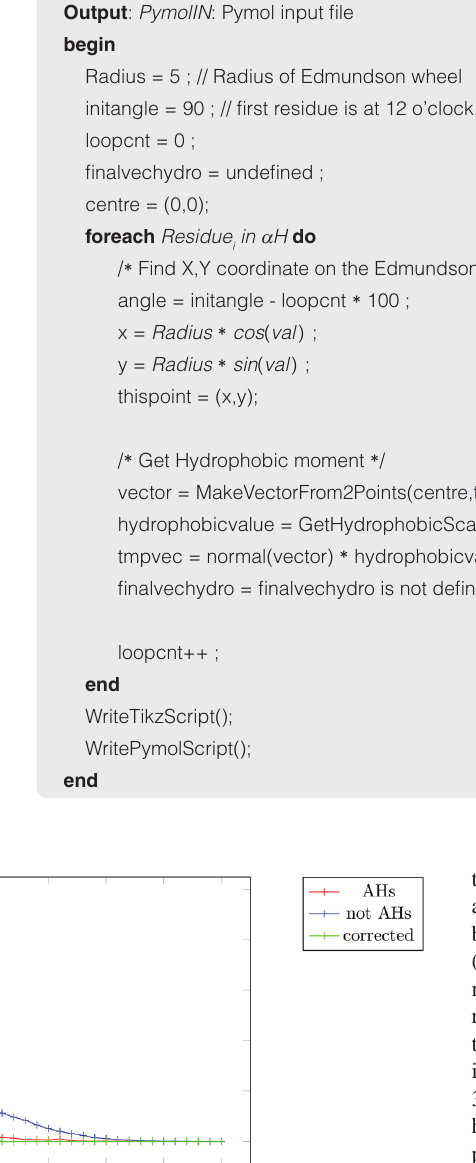
) and D( O /C α / i i +4 i